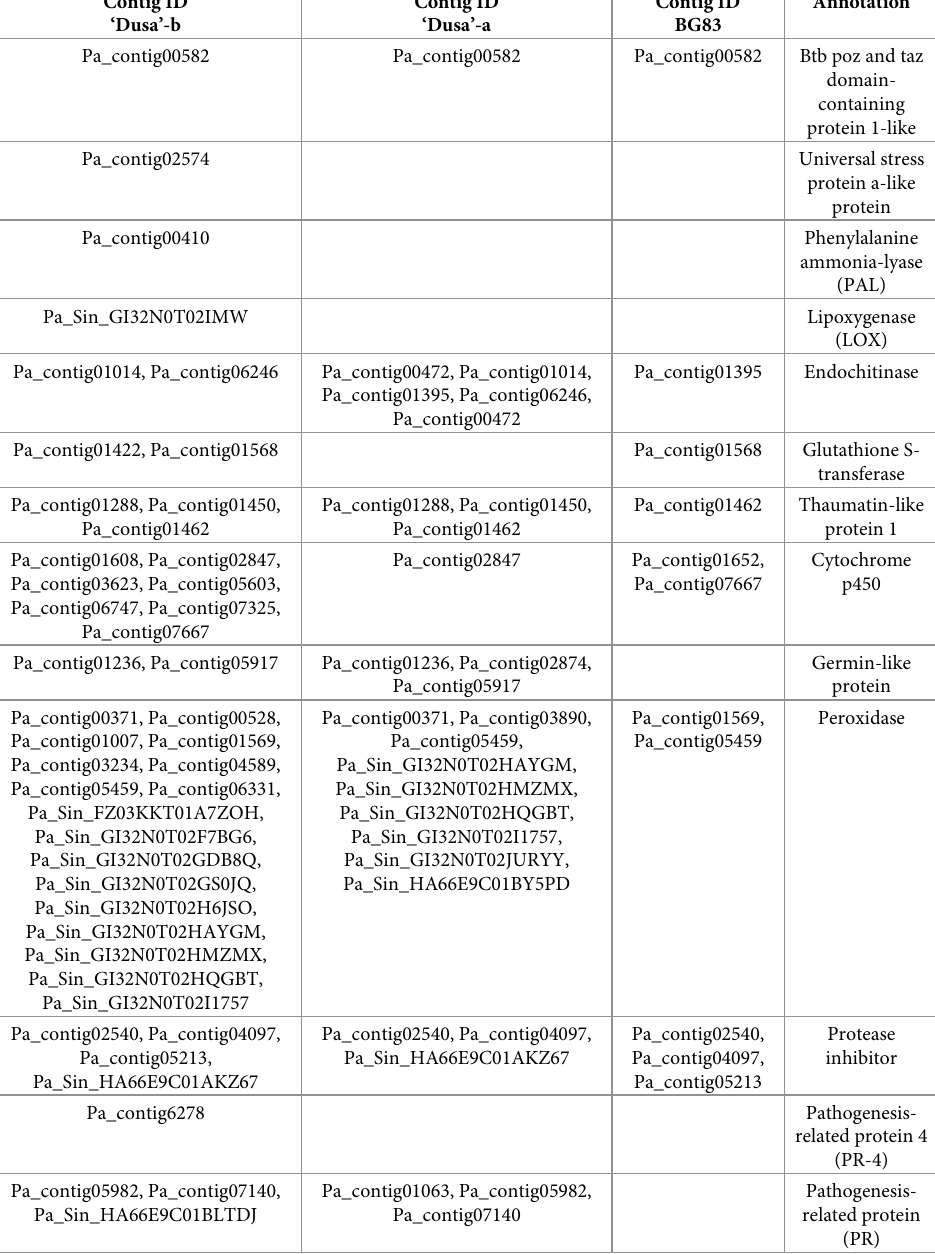
Table 3. Defence-related genes overexpressed in ‘Dusa’-b, ‘Dusa’-a and BG83 avocado rootstock following R . necatrix